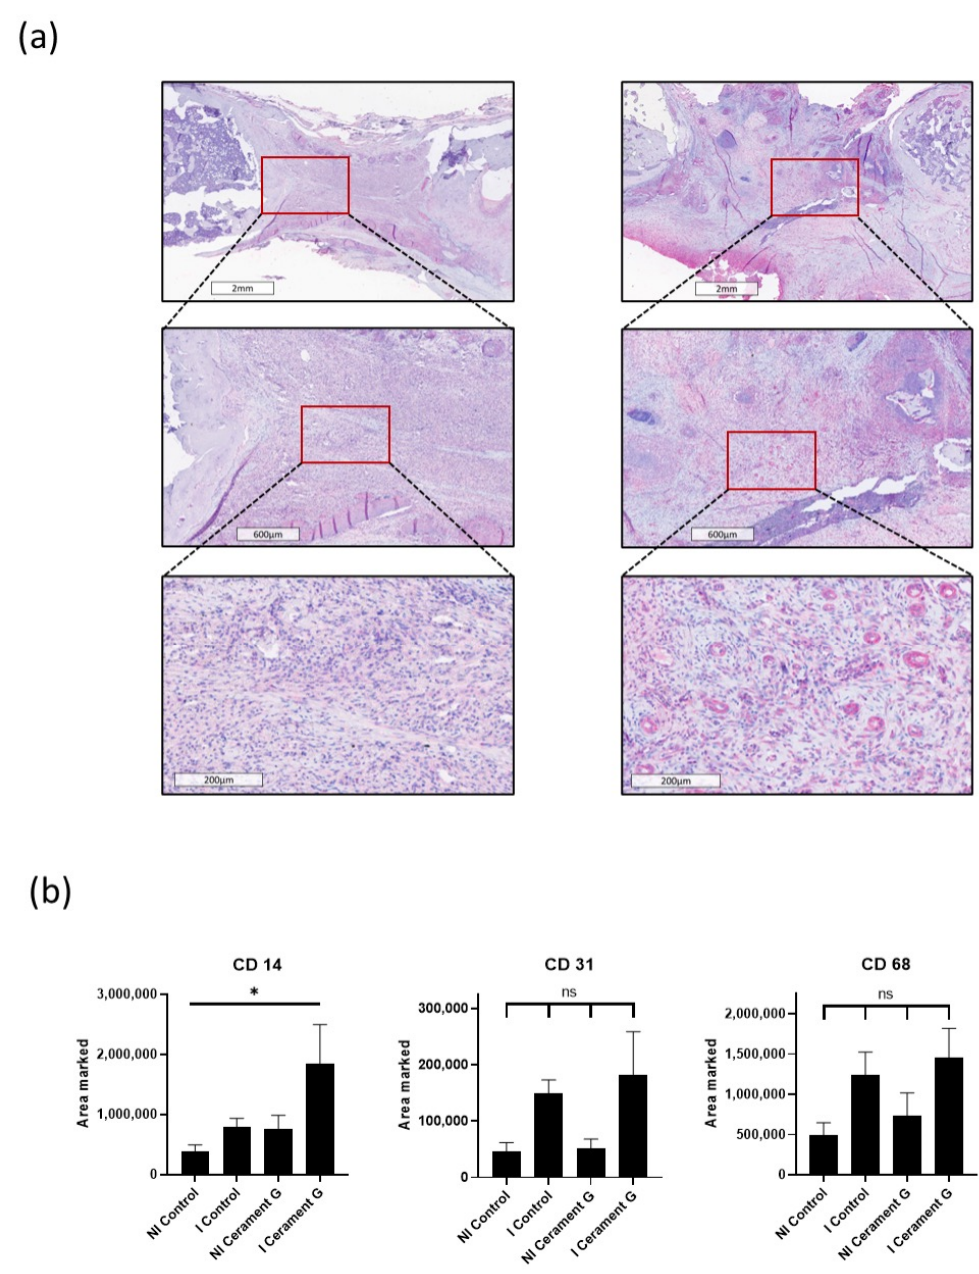
Figure 5. ( a ) CD14 staining, a marker for macrophages. Comparison of representative parts of the bone defect with magnification of the bone–defect border. ( b ) Significant increased infiltration of macrophages (CD14) in the I Cerament G compared with the NI Control, * = p < 0.05. CD31 staining, a marker for vascularization, and CD68 staining, a marker for macrophages, show no significant differences.